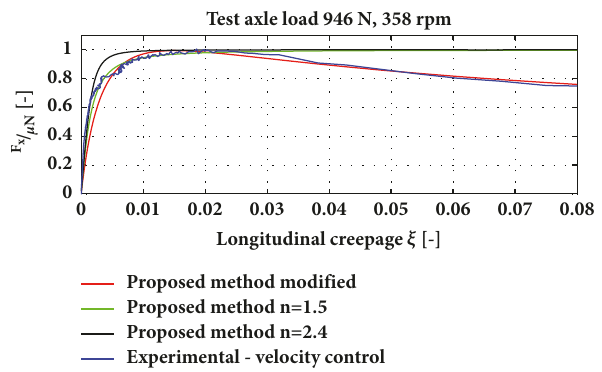
Figure 15: Normalized longitudinal tangential force on roller-rig, with an axle load of 946 N and a reference velocity of 358